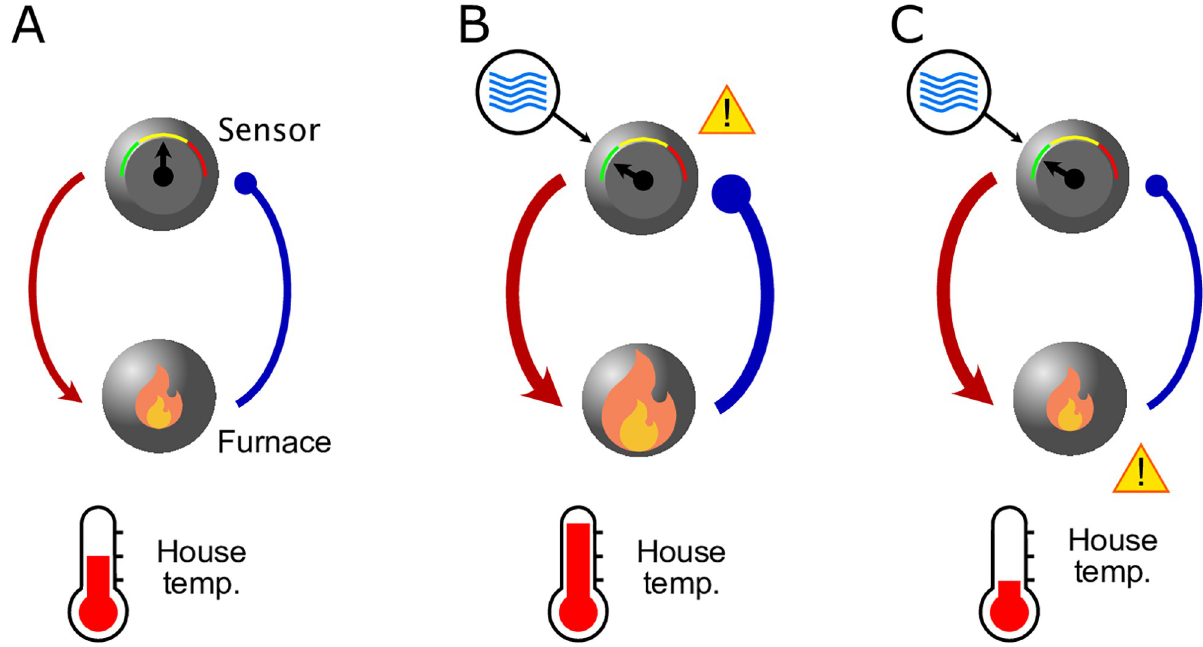
Fig 2. Internal dynamics can cause very simple systems to respond differently to the same intervention. (A) Suppose a heating system, comprised of a thermostat sensor and furnace malfunctions and the house is too cold. (B) If the sensor is defective, opening a window near the sensor might “stimulate” it, thereby increasing the furnace’s output and warming the house. (C) However, if the furnace is broken, this cools the house